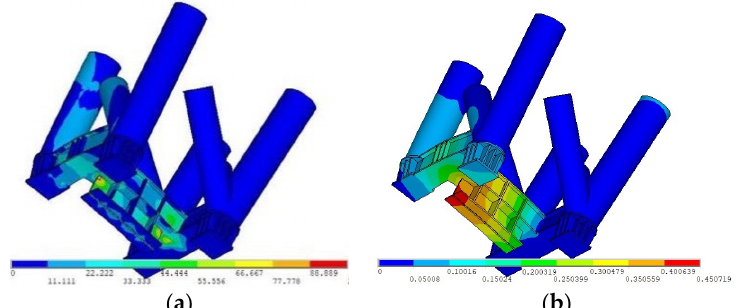
Figure 17. Cloud diagram of slipper stress and deformation (mm). ( a ) Stress cloud diagram, ( b ) deformation cloud diagram.